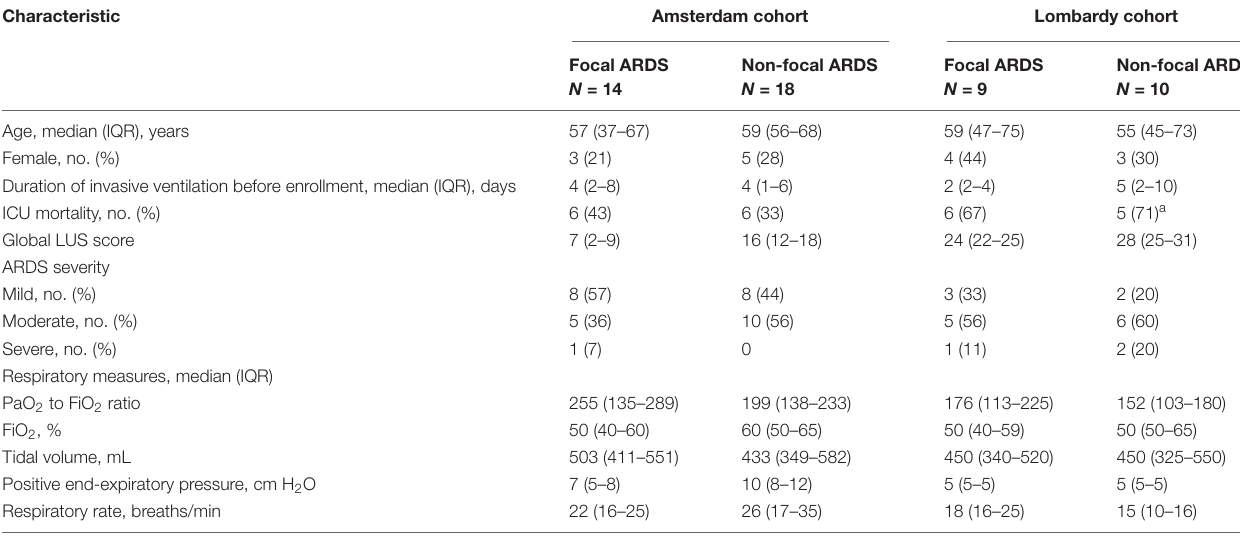
TABLE 1 | Characteristics of the patients included in the Amsterdam and Lombardy cohorts examined with lung ultrasound and computed tomography. Characteristic Amsterdam cohort